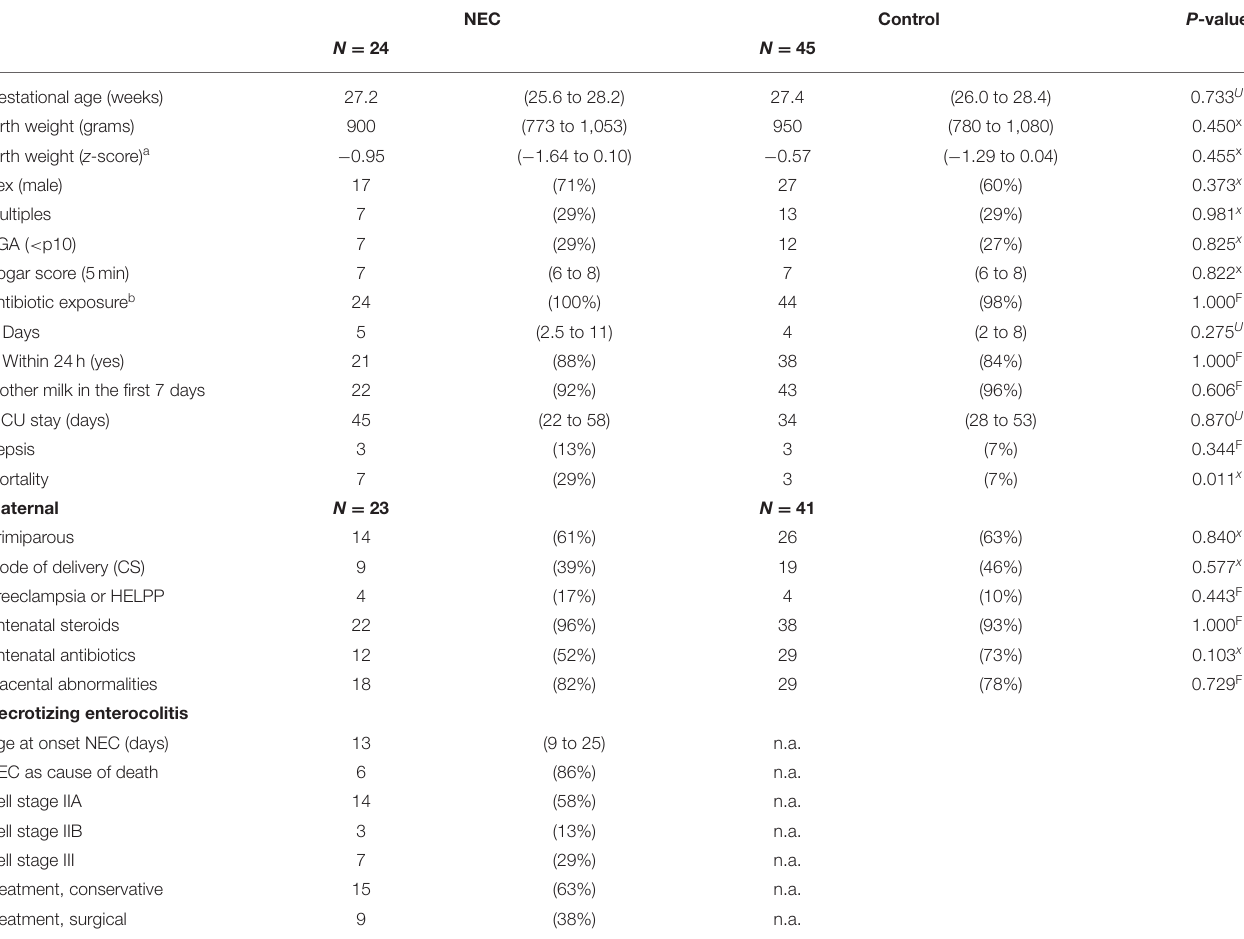
TABLE 2 | Characteristics of the NEC infants and control